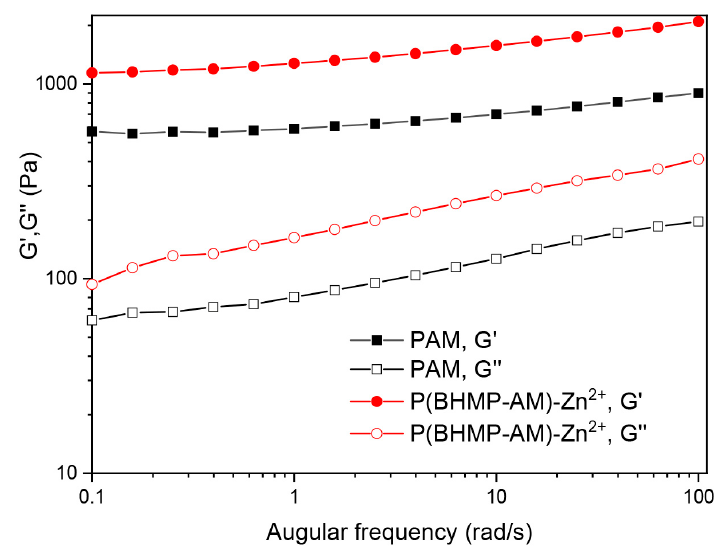
Figure 8. G ′ and G ″ scans for the PAM and P(BHMP-AM)-Zn 2+ hydrogels. Figure 8. G (cid:48) and G (cid:48)(cid:48) scans for the PAM and P(BHMP-AM)-Zn 2+